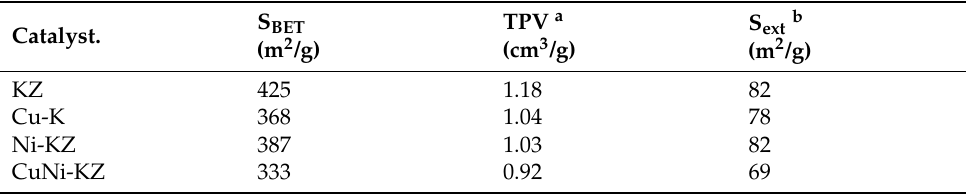
Figure 7. Nitrogen physisorption isotherms of the composite mesoporous materials. Table 3. Textural properties of the studied